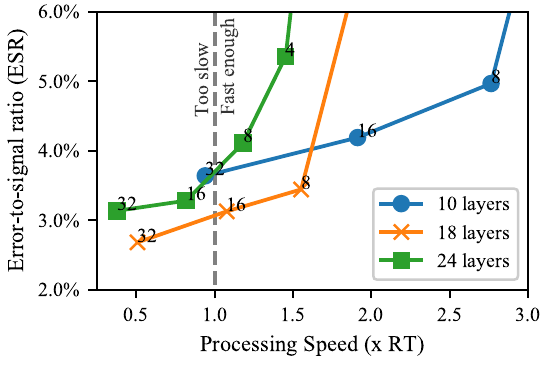
Figure 6. The validation error-to-signal ratio (ESR) as a function of the processing speed, using different numbers of layers and convolution channels. All models shown use the gated activation. The number of convolution channels used is indicated next to each model.